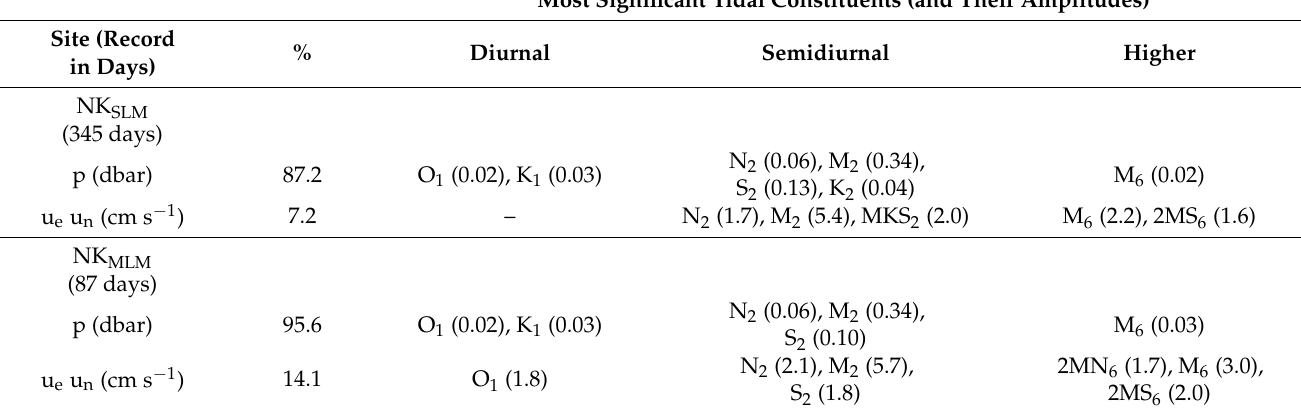
Table 4. Tidal analysis for bottom pressure and flow record based on the harmonic analysis toolbox T_Tide [82]. Shown are the harmonics with amplitudes >0.02 dbar and >1.5 cm s − 1 for pressure and flow, respectively, in three categories: diurnal, semidiurnal, and short period constituents. Explained variance through the tidal model in percent is given next to the parameter. Abbreviations: p: pressure, u e u n : bottom horizontal